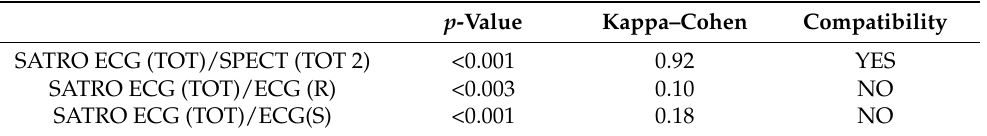
Table 4. The results of the Kappa-Cohen test and the values of statistical significance coefficients ( p ) for the correlation of SATRO ECG (TOT) with other